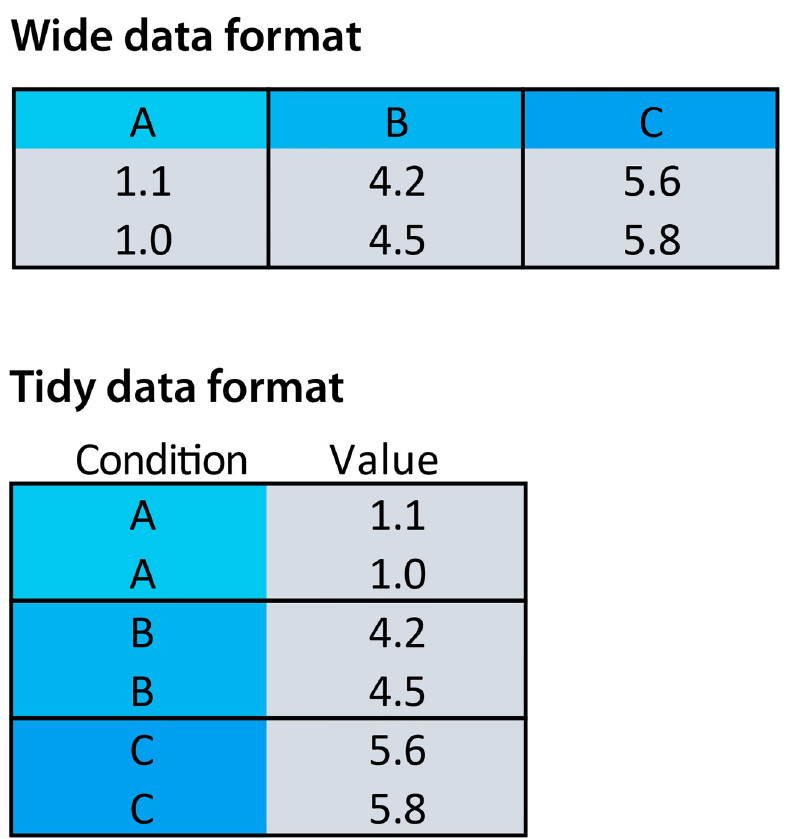
Fig 1. The wide versus tidy data format. In the wide (spreadsheet-like) data format each column represents a condition. In the tidy format each column is a single variable and each row is an observation.